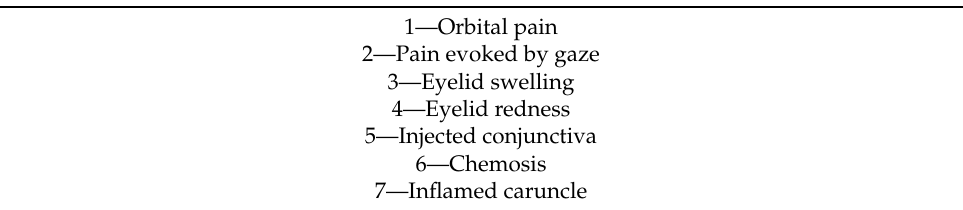
Table 1. Clinical activity score (CAS)